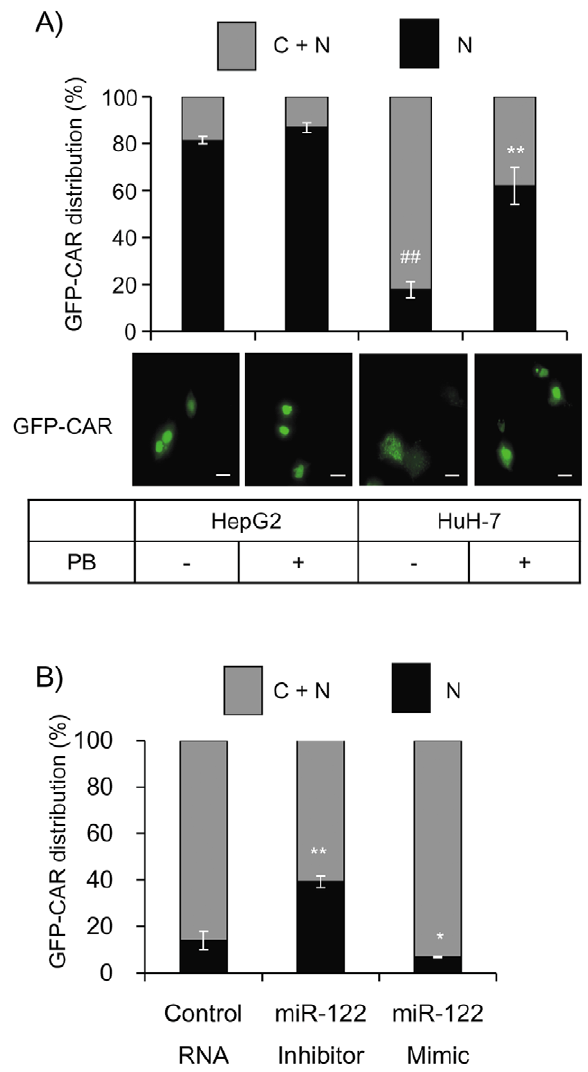
Figure 6. Modulation of miR-122 induces changes in GFP-CAR distribution in HuH-7 cells. A , HepG2 and HuH-7 cells were transfected with CAR/pQBI25. Cells were treated with PBS or PB 24 h after transfection and fixed 4 h after the treatment with 2% para- formaldehyde. Subcellular localization of the GFP fusion protein was observed by Keyence BZ-8000 microscope using a x20 objective lens (lower panel; scale bar, 20 m m). The distribution pattern were scored for at least 100 transfected cells, which were randomly observed, and classified into 2 categories; C + N, equal distribution to the nuclear and the cytoplasmic compartments; N, the nuclear dominant distribution. Data are illustrated as the % of total cells (n=3). ## , p , 0.01 vs the vehicle treated HepG2 cells; **, p , 0.01 vs the vehicle treated HuH-7 cells. B , HuH-7 cells were transfected either with the miR-122 inhibitor, the mimic or the control RNA (20 pmol) in conjunction with CAR/ pQBI25 vector (0.2 m g). Cells were fixed 48 h after transfection and the subcellular localization of the GFP-derived fluorescence was monitored as described above. Data are illustrated as the % of total cells (n=3). *, p , 0.05; **, p , 0.01 vs cells transfected with the control